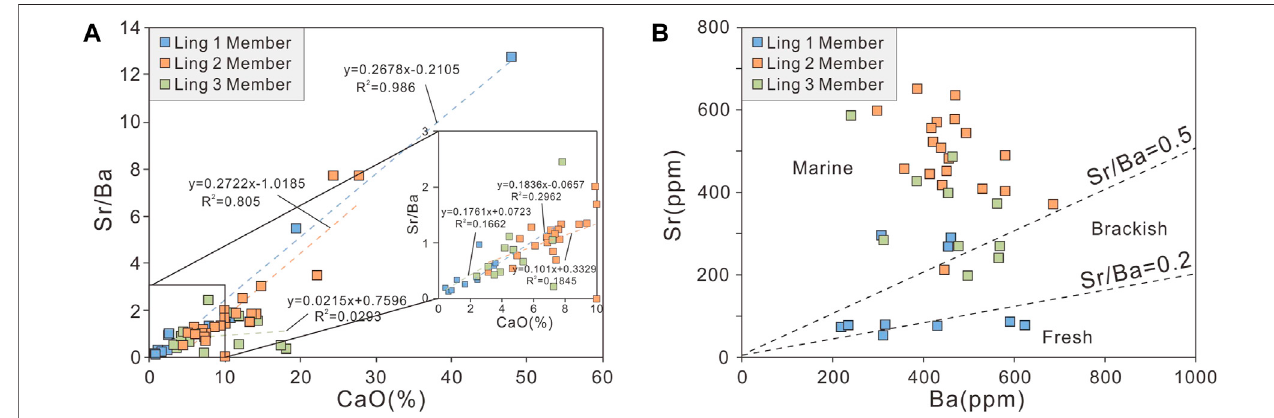
FIGURE 10 | (A) Crossplot between Sr/Ba ratios and CaO concentration of Linghao Formation. (B) Paleo-water salinity facies for Linghao Formation.